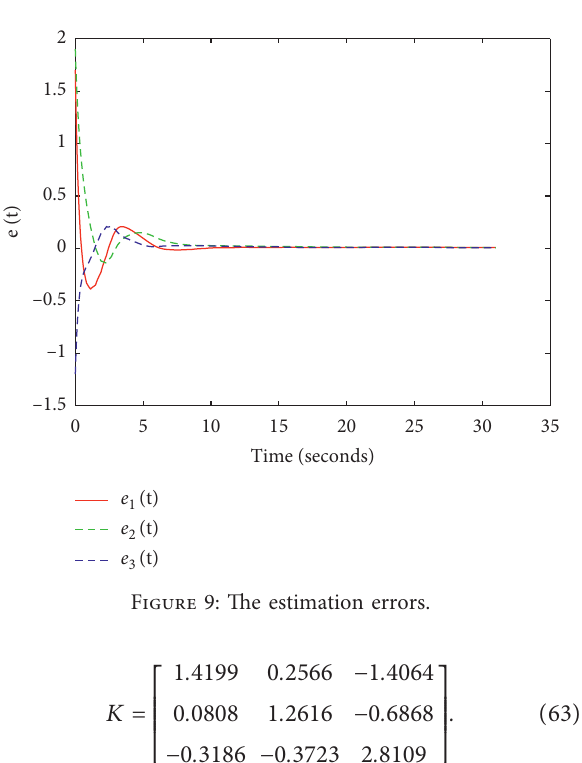
Figure 9: The estimation errors.